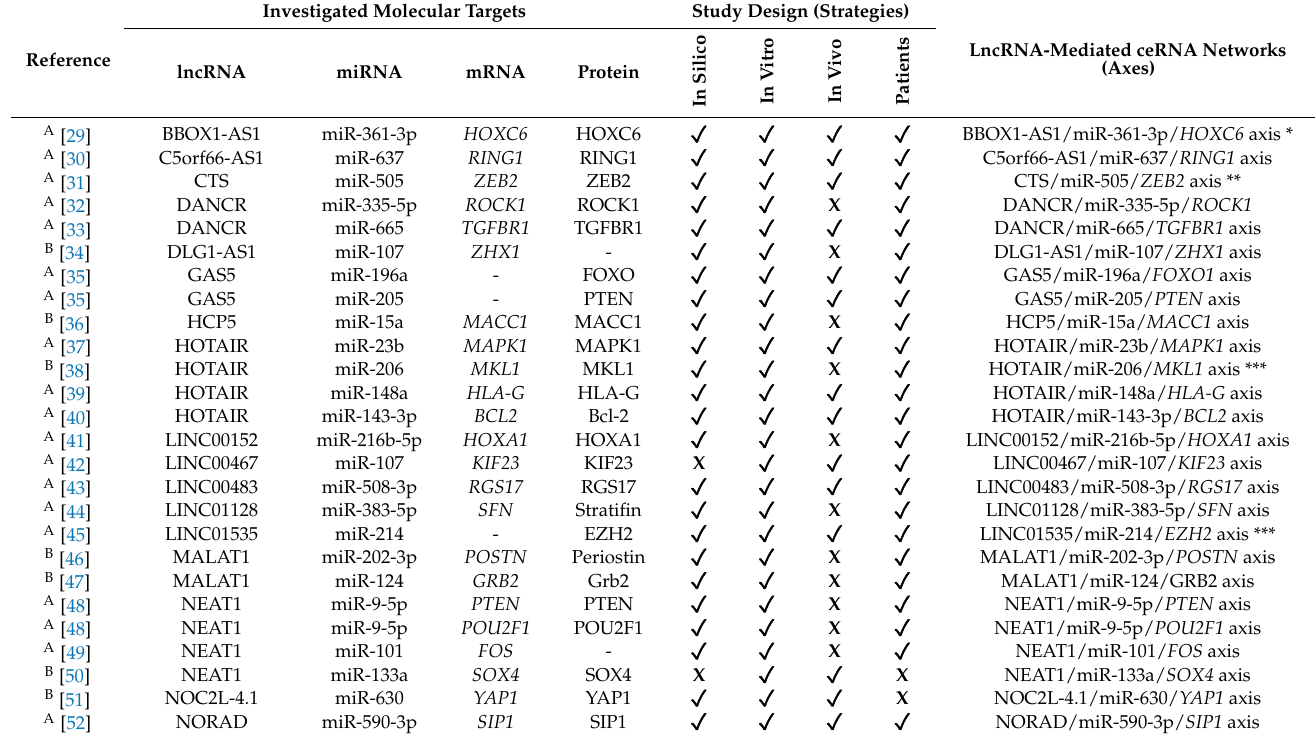
Table 1. Summary of studies investigating lncRNA-mediated ceRNA networks involved in cervical carcinogenesis.